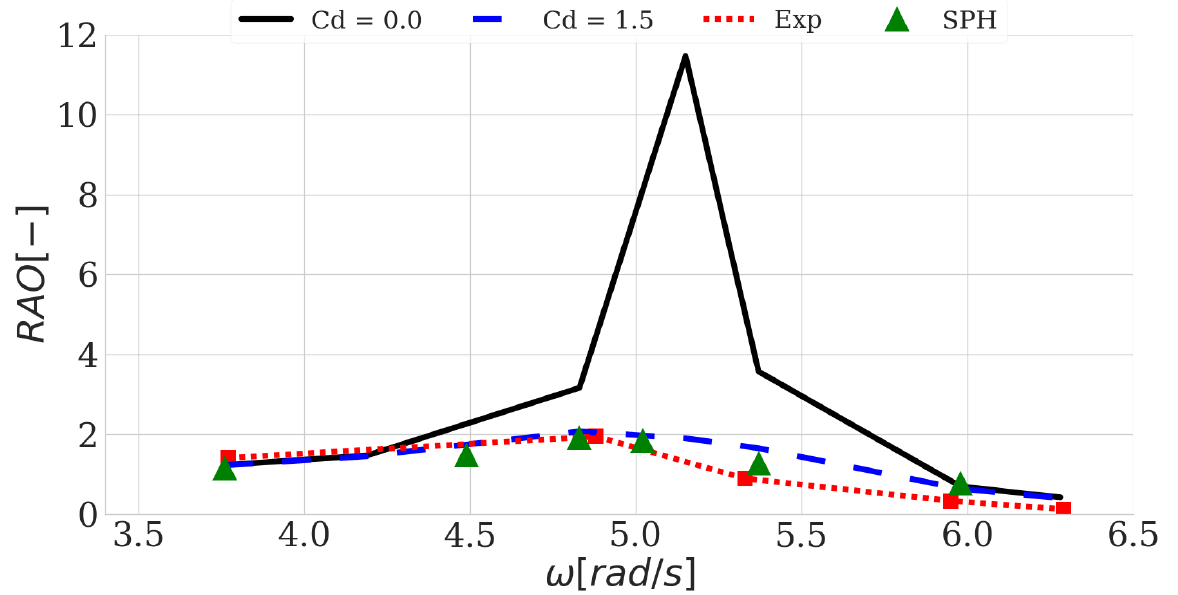
Figure 9. Response amplitude operator (RAO) for the cylindrical WEC cylinder2 without a power take-off (PTO) system, calculated with (i) linear potential flow theory with C d = 0.0, (ii) linear potential flow theory with C d = 1.5, (iii) SPH–DualSPHysics and (iv) obtained from experiments [34], H = 0.08